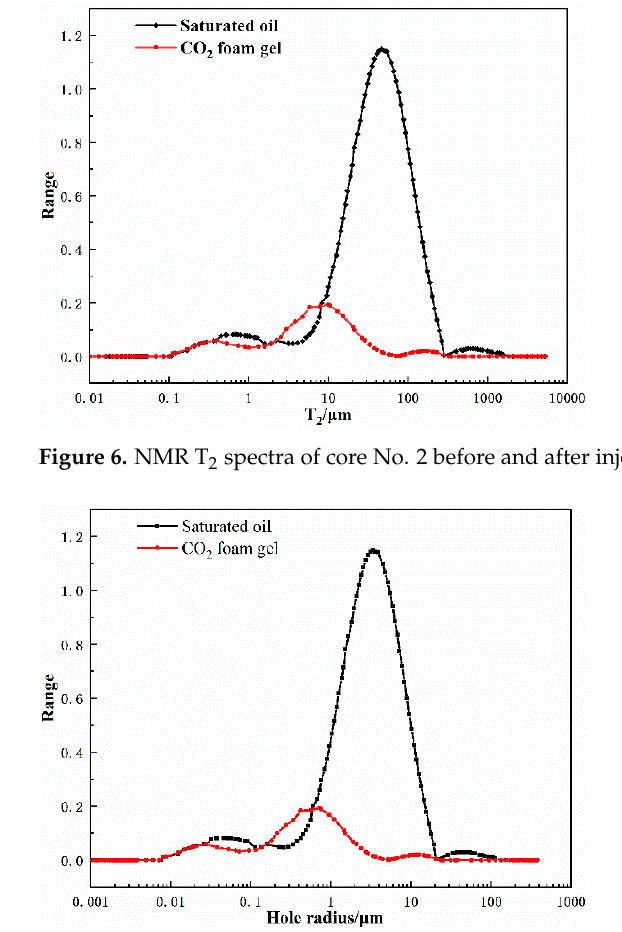
Figure 7. Pore throat radius distribution before and after injection of CO 2 foam gel in core